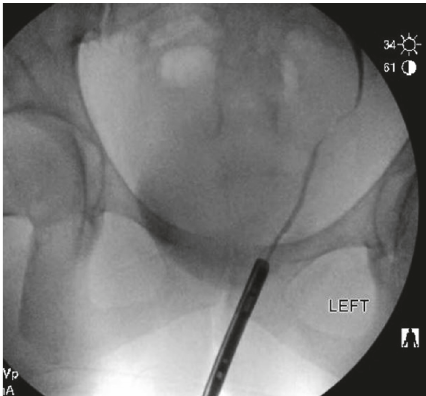
Figure 4: Left retrograde pyelogram shows 1.5 cm distal ureteral stricture with mild hydroureteronephrosis.